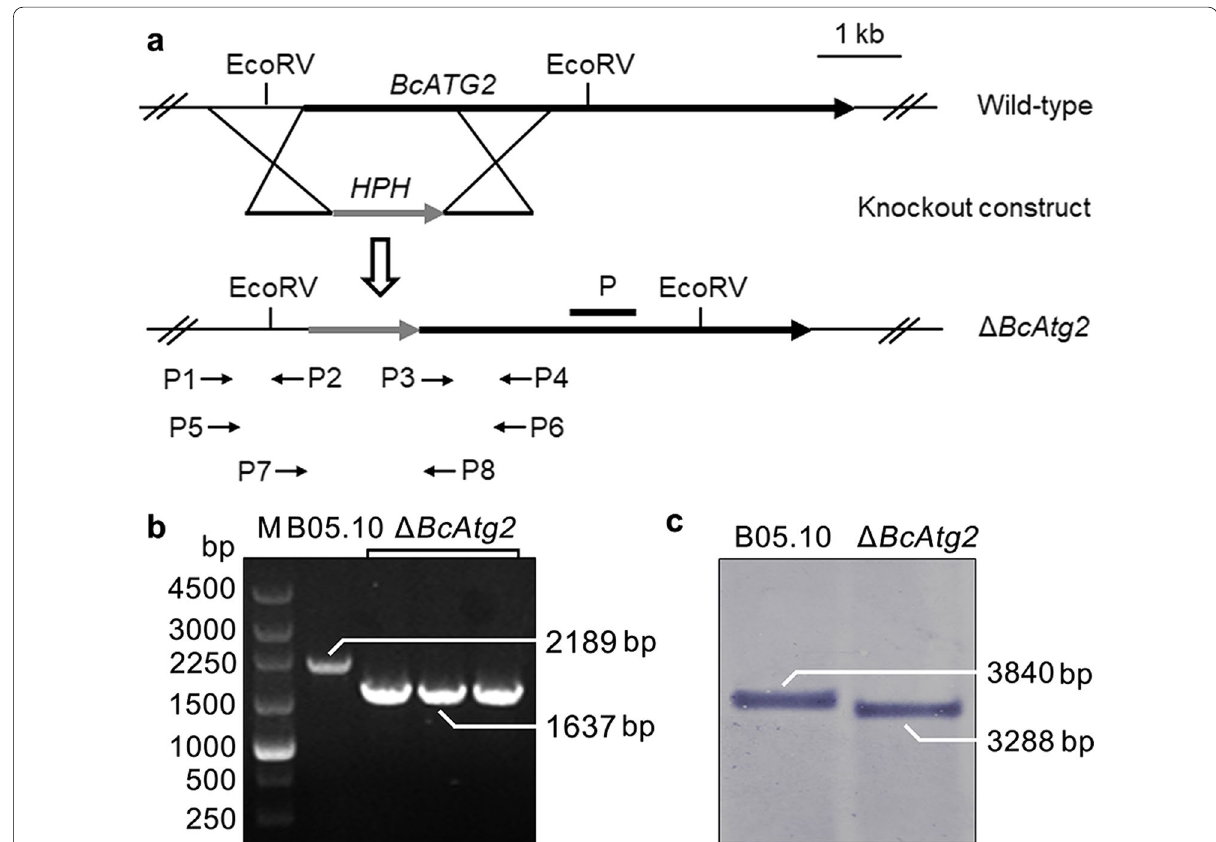
Fig. 2 Targeted deletion of BcATG2 in B. cinerea . a Schematic representation of the strategy used to generate the BcATG2 deletion mutant. b PCR-based identification of the BcATG2 deletion mutant. c Southern blot analysis of the BcATG2 deletion mutant. The genomic DNA of each strain was digested with EcoRV restriction